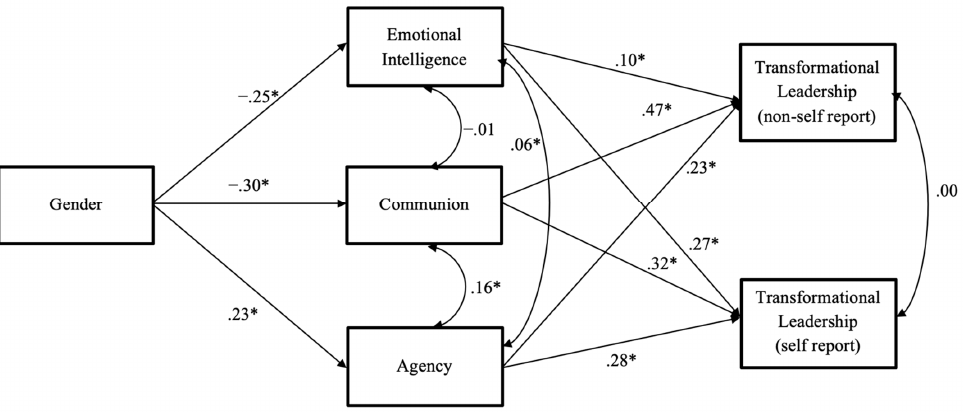
Figure 4. Path Model Results for the Personality-Based Model of Female Leadership Advantage (Model 2a). Note. Standardized path coefficients ( β ’ s) are presented. N = 420; χ 2 (2) = 2.513; RMSEA